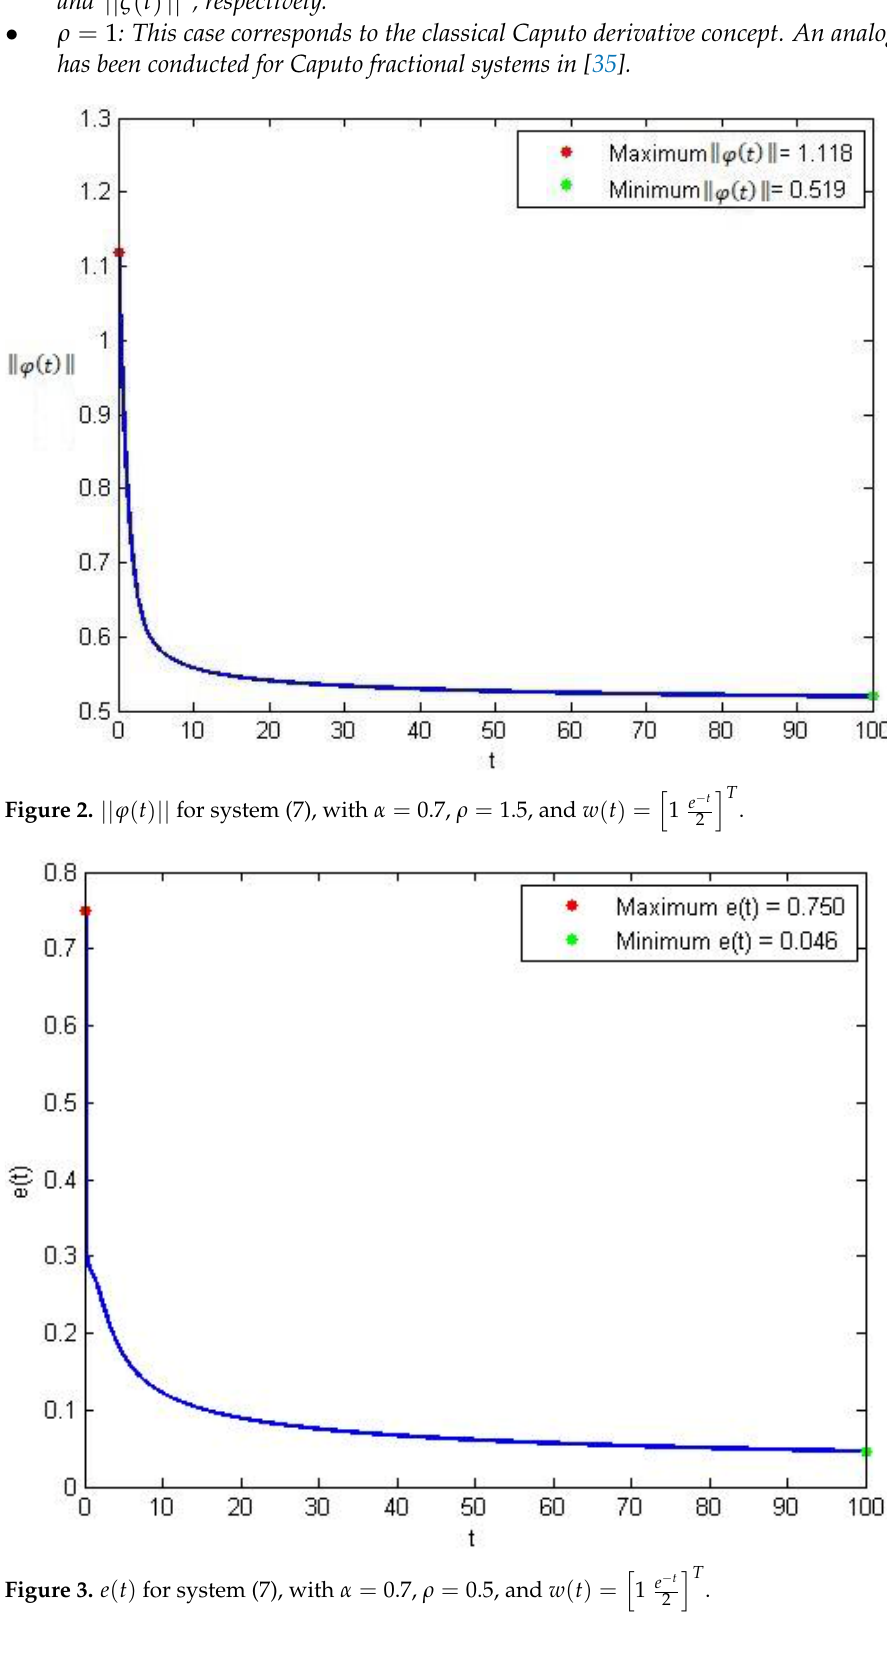
Figure 3. e ( t ) for system (7), with α = 0.7, ρ = 0.5, and w ( t ) = Figure 3. 𝑒(𝑡) for system (7), with 𝛼 = 0.7 , 𝜌 = 0.5, and 𝑤(𝑡) = [1 𝑒 Figure 3. 𝑒(𝑡) for system (7), with 𝛼 = 0.7 , 𝜌 = 0.5, and 𝑤(𝑡) = [1 𝑒